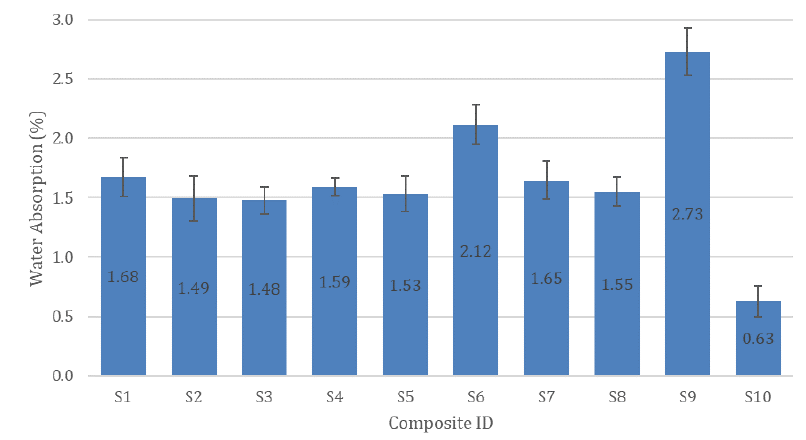
Figure 15: Average water absorption of fabricated composite